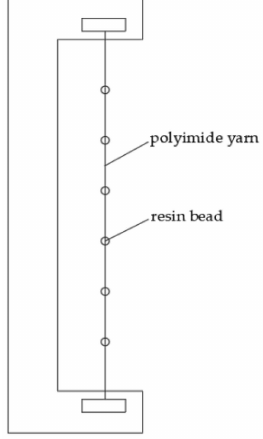
Figure 1. The sample being extracted.